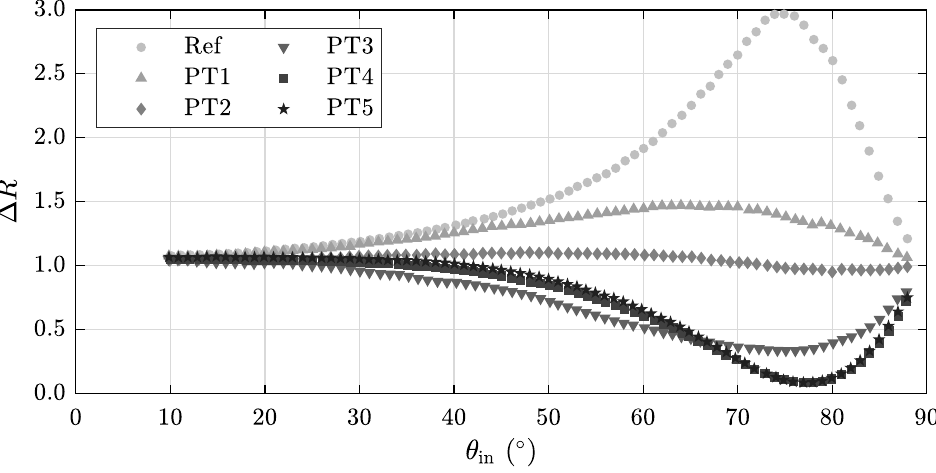
Figure 6. Angle-dependency of ∆ R ( θ in ) using a wavelength of